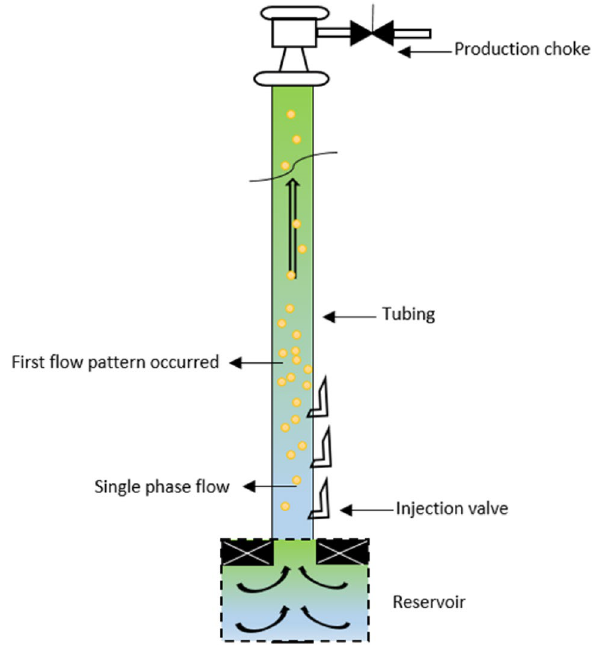
Fig. 1 Typical gas lift well